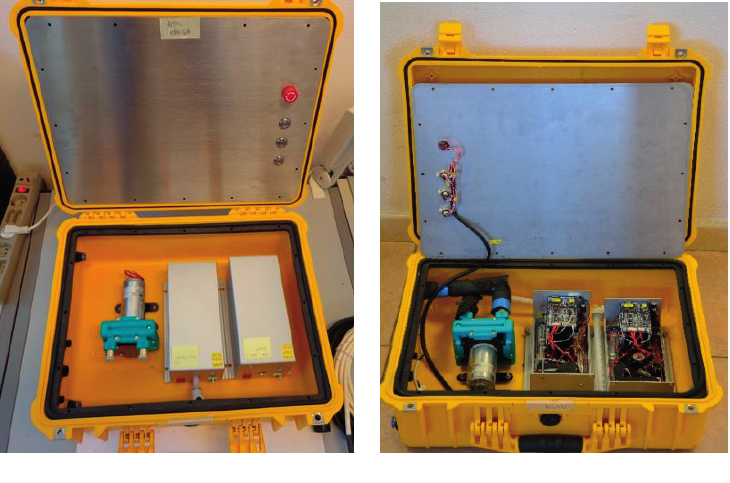
Figure 14. The hydraulic and measuring unit: The measuring unit with the area closed ( Left ) and the measuring unit with the area open ( Right